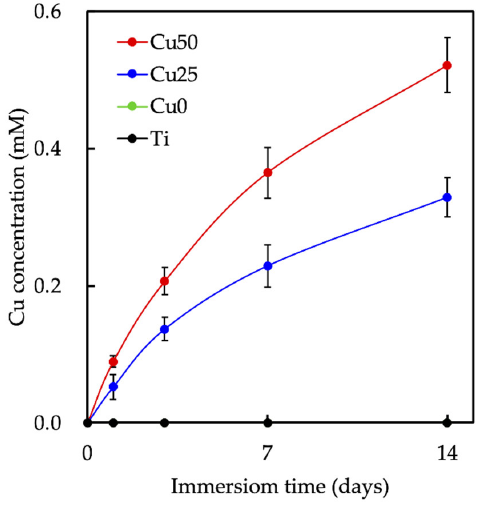
Figure 7. The concentration of Cu released from the scaffolds immersed in medium. Data presented as mean ± SEM, n = 6 for each